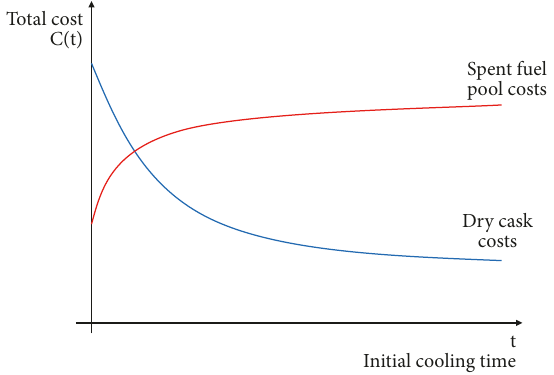
Figure 3: Illustrative sketch of the behavior of the contributions to the spent fuel storage costs.